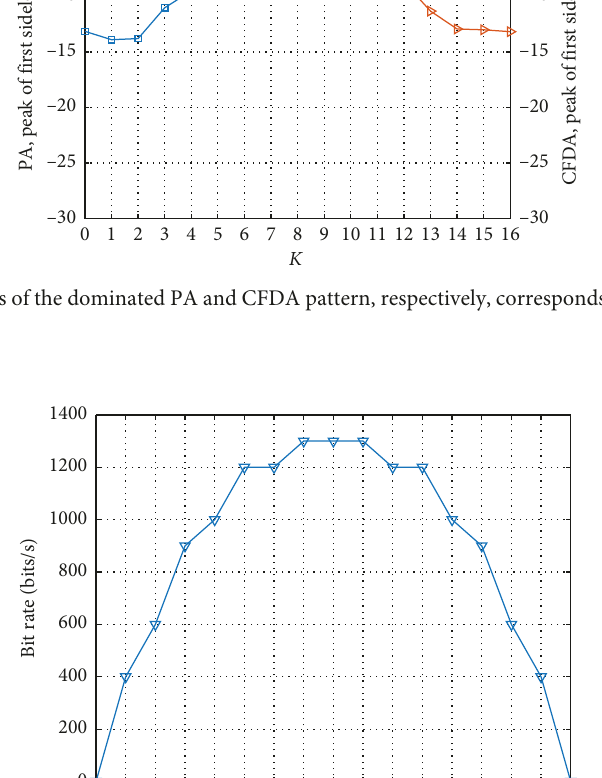
16, ∆ f 3kHz, and T s (cid:31) (cid:31)